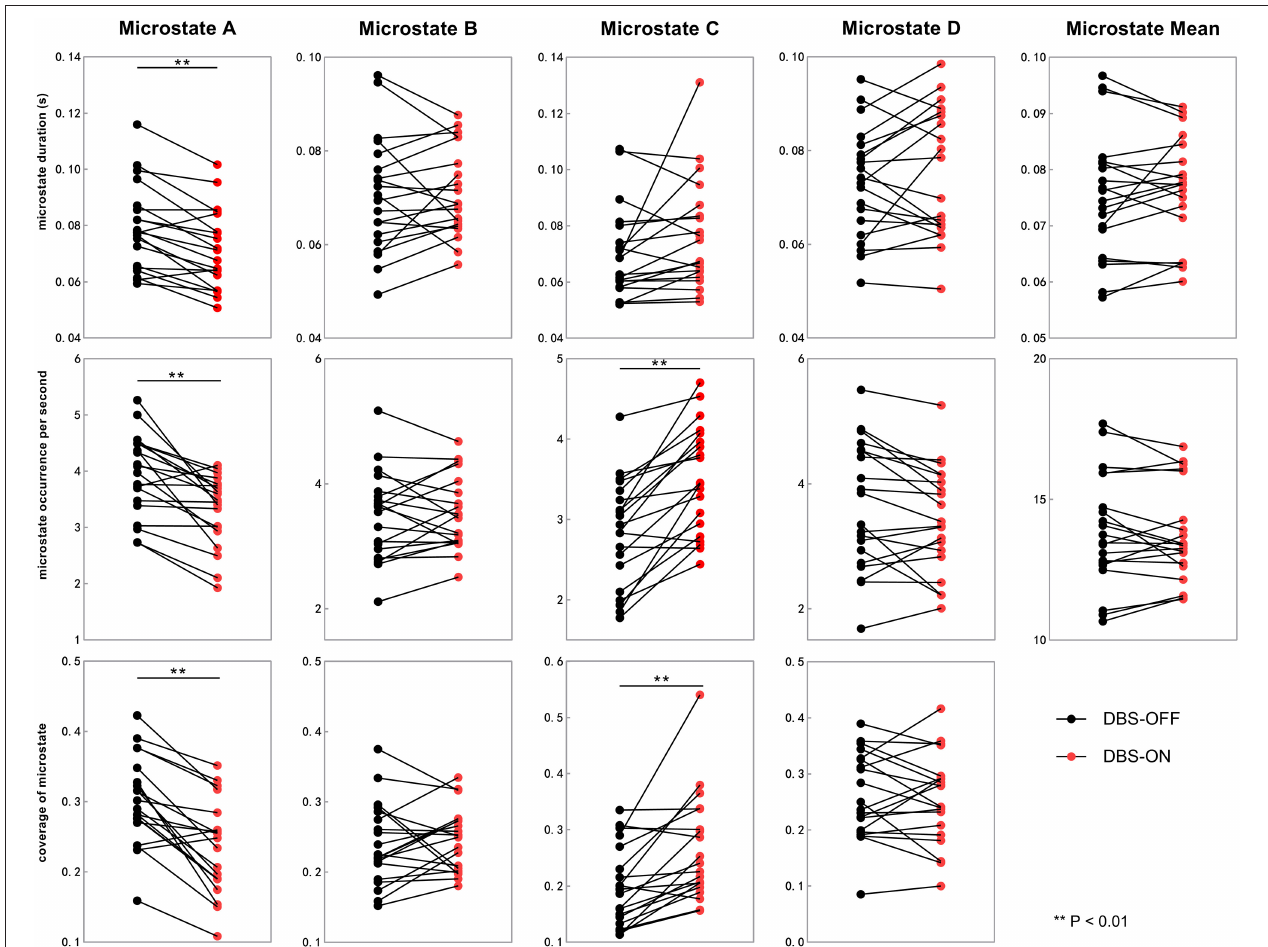
FIGURE 3 | Temporal characteristics of microstate between DBS-OFF state and DBS-ON state. All the microstate temporal parameters decrease after DBS in microstate class A. In addition, the occurrence rate and coverage of microstate class C increase. DBS, deep brain stimulation.